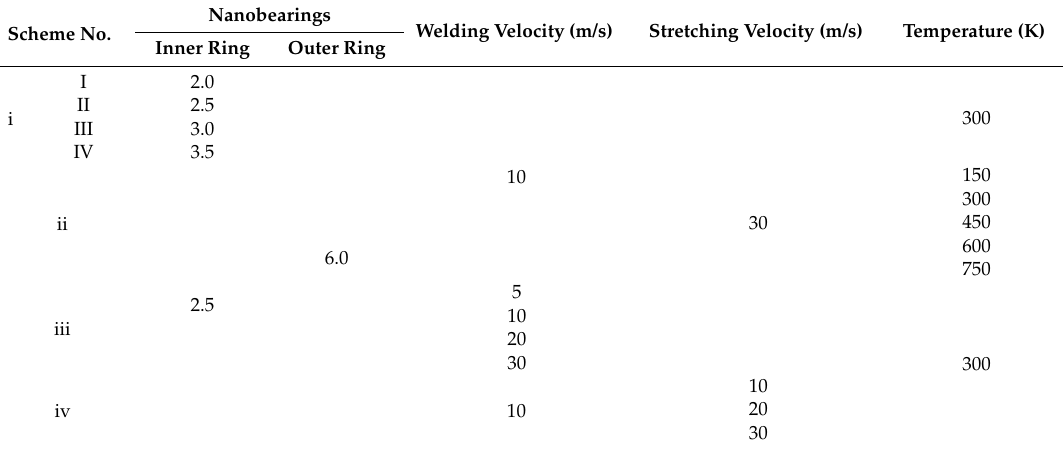
Table 1. Summary of the two schemes of copper bearing-sleeve at the nanoscale. Scheme